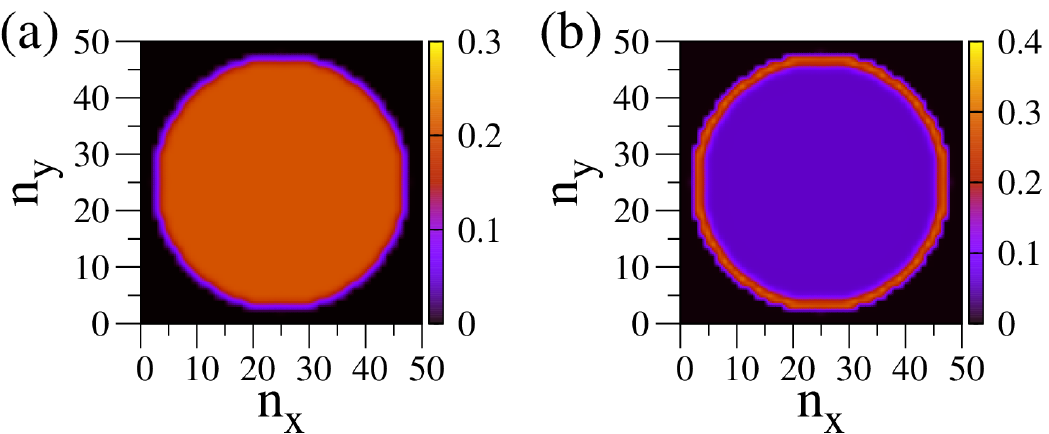
Figure 6: (a) A color map of the real-space particle distribution of the dissipative Hofstadter model on a 50 × 50 lattice with in a circular trap [ simulated by adding a large state-independent evaporation rate outside the trap to L out , Eq. (7) ] . Inside the trap the density ≈ 1 / q = 1 / 5 atoms per unit site, since only the lowest band of the reference Hamiltonian (13) is filled. The parameter values are as in Fig. 3. (b) A color map of the derivative of the local particle number with respect to γ in / ( 2 πν It is significant only near the edge, thus revealing the edge modes from Fig.